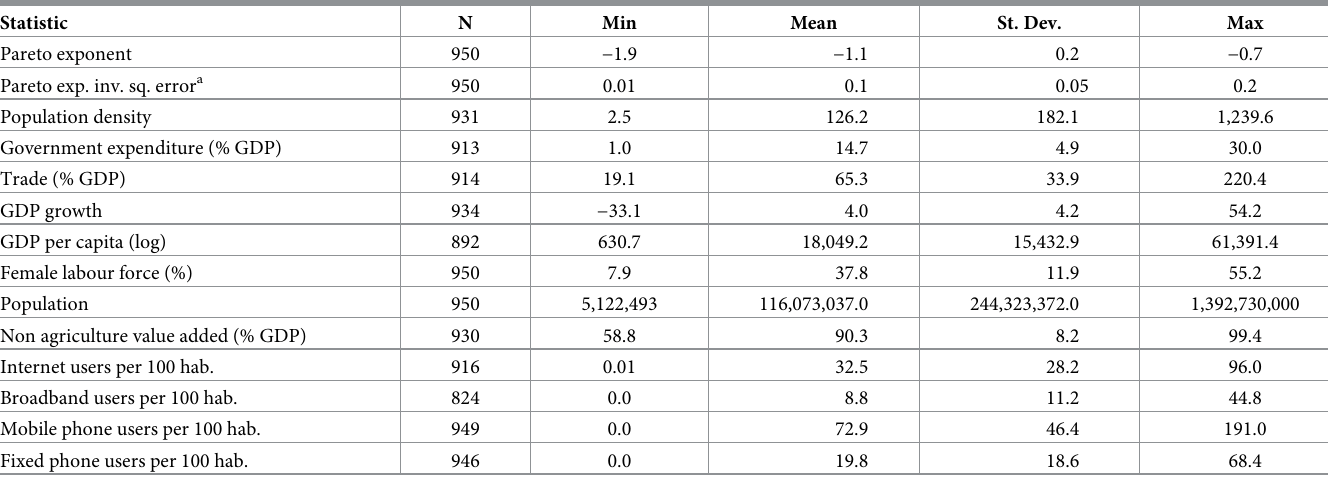
Table 2. Descriptive statistics for the multi-country model.